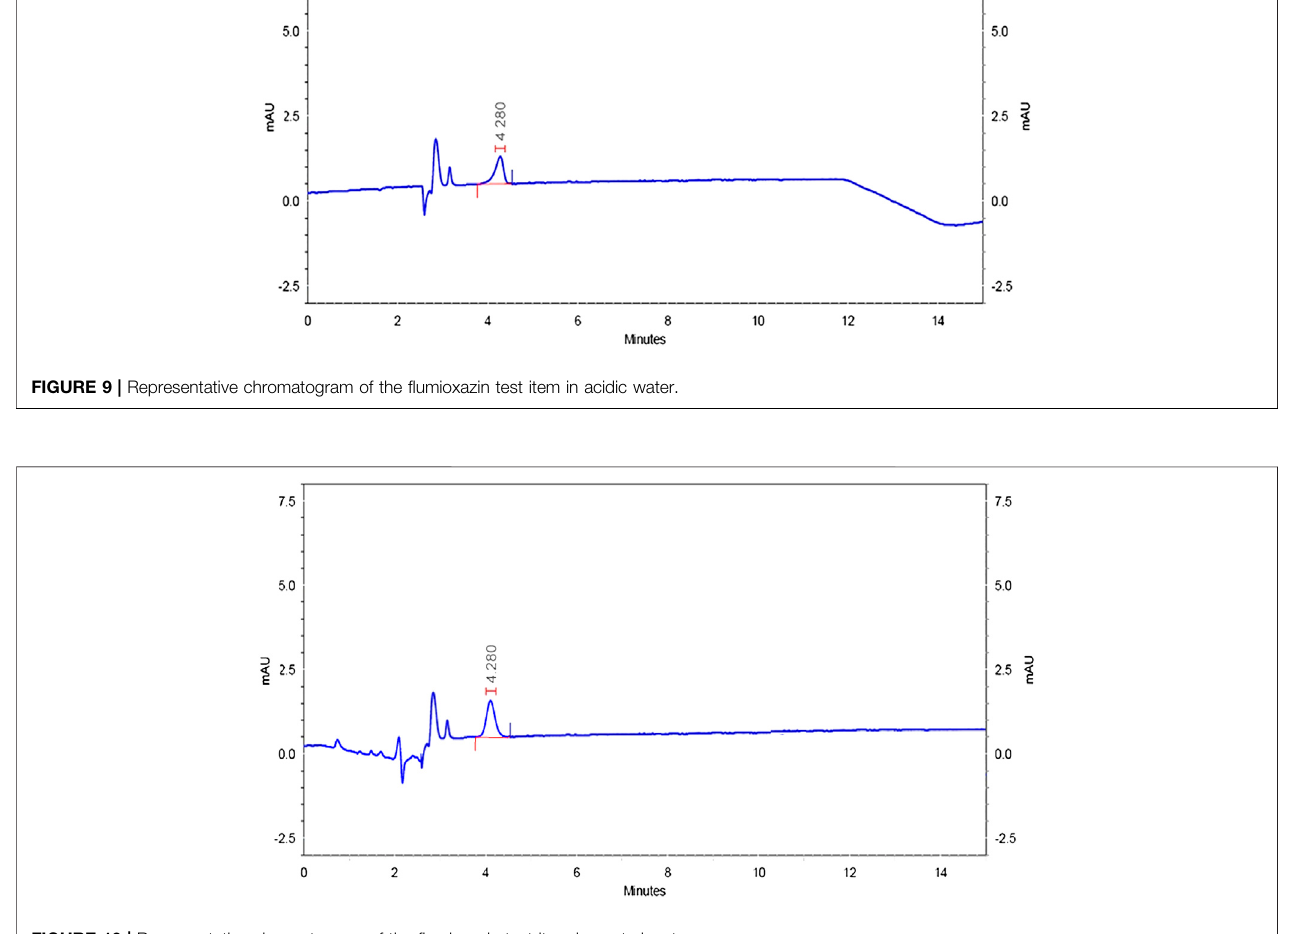
FIGURE 10 | Representative chromatogram of the fl umioxazin test item in neutral water.